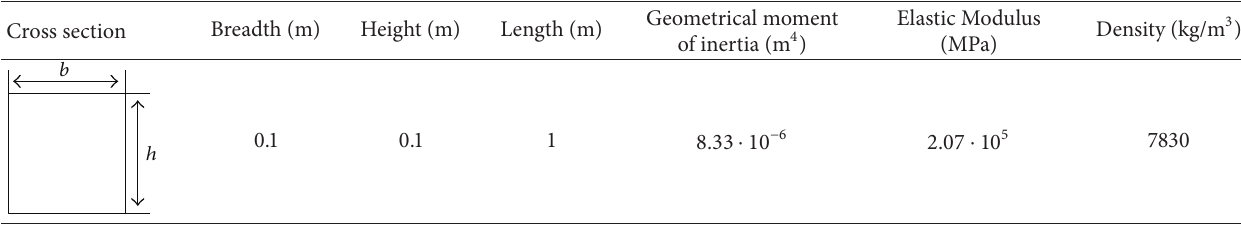
Table 2: Detailed properties of